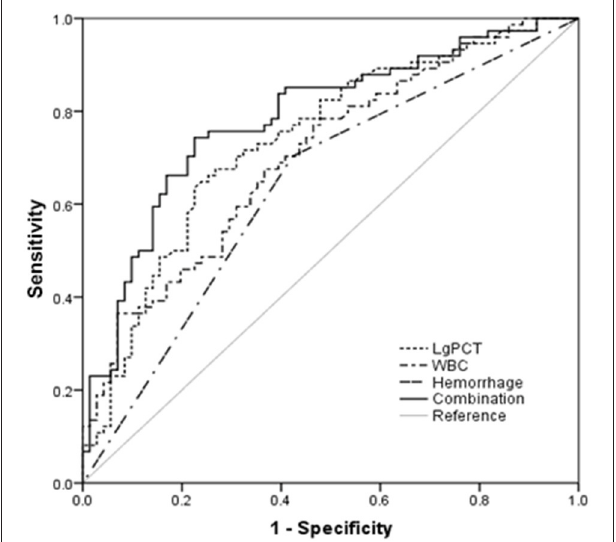
FIGURE 1 | Procalcitonin (PCT) and white blood cell (WBC) at admission and the occurrence of hemorrhage in predicting the severity of hemorrhagic fever with renal syndrome (HFRS) by receiver operating characteristic curve (ROC)